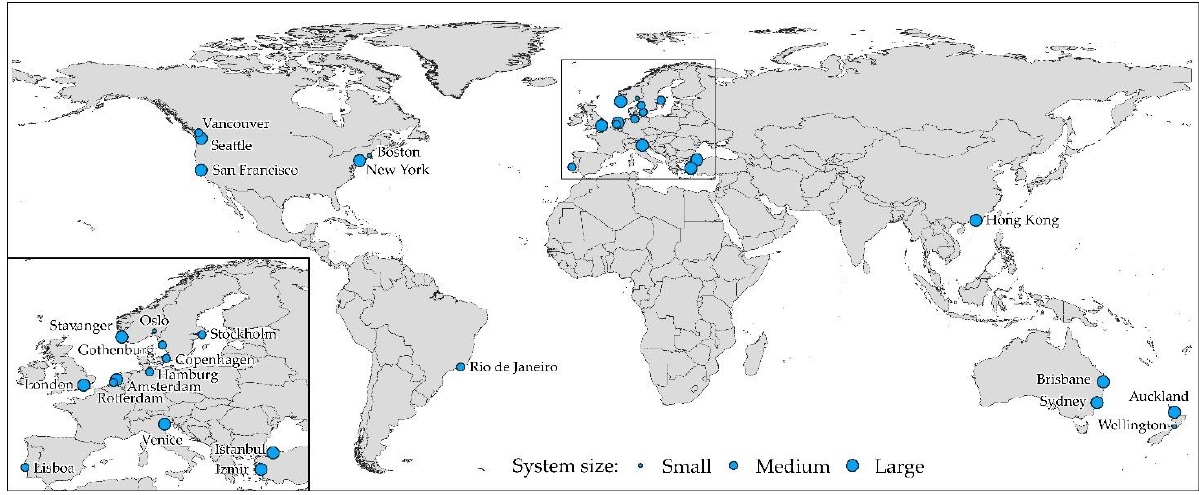
Figure 2. Location of analysed urban water transit systems.